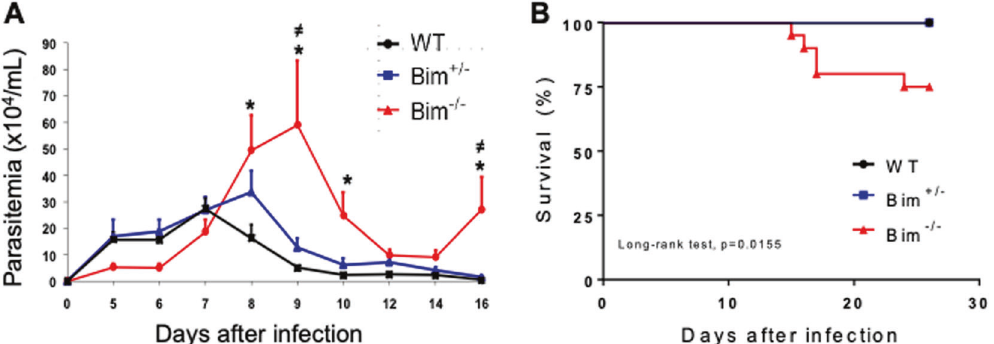
Fig. 1 Bim − / − mice are susceptible to T. cruzi infection. C57BL/6 WT, Bim + / − , and Bim − / − mice were inoculated i.p. with 1 × 10